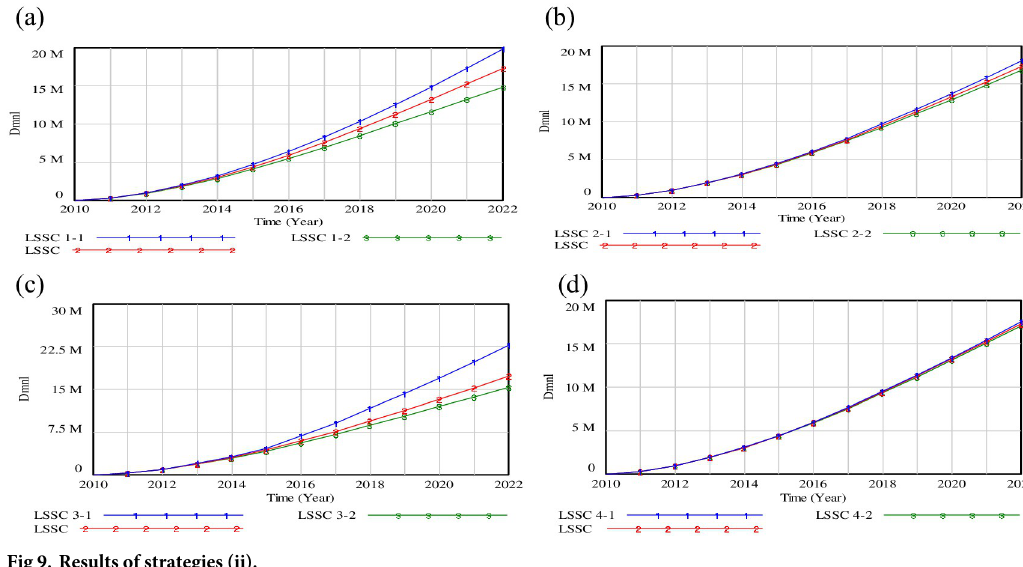
Fig 9. Results of strategies